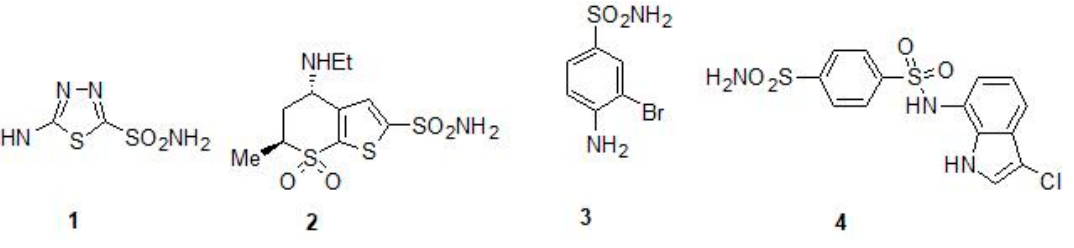
Chemical structures of acetazolamide ( 1 ) (ATZ), dorzolamide ( 2 ) (DZA), 3-bromosulfanilamide ( 3 ) and indisulam ( 4 ).